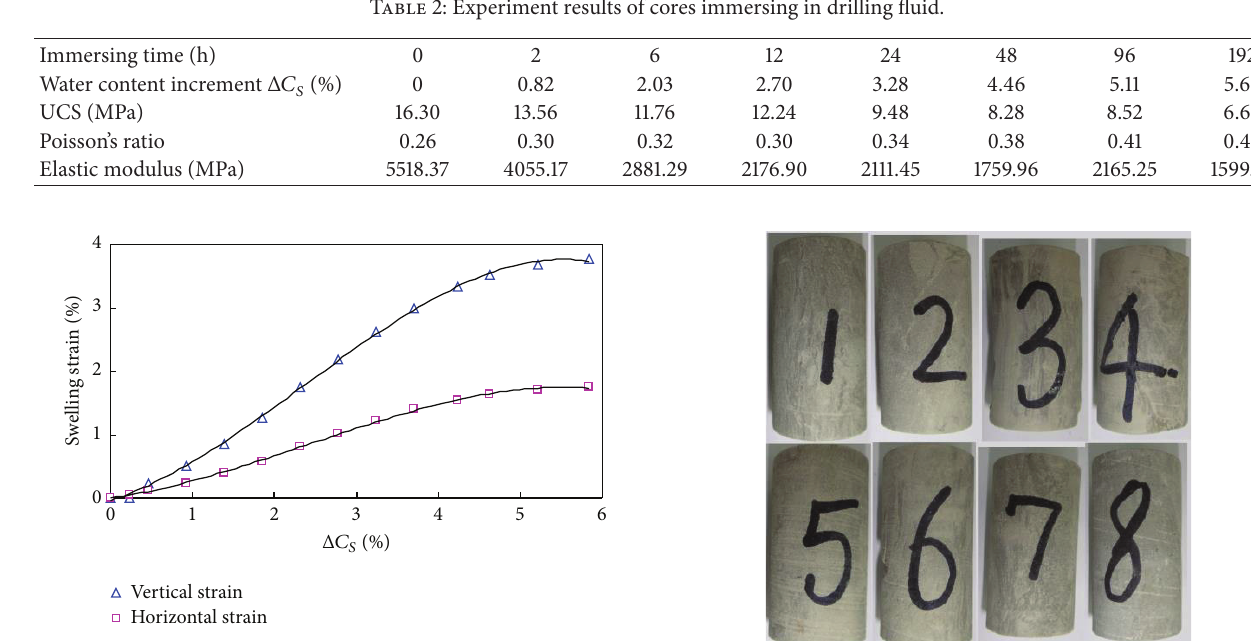
Figure 4: Experimental results of shale swelling.